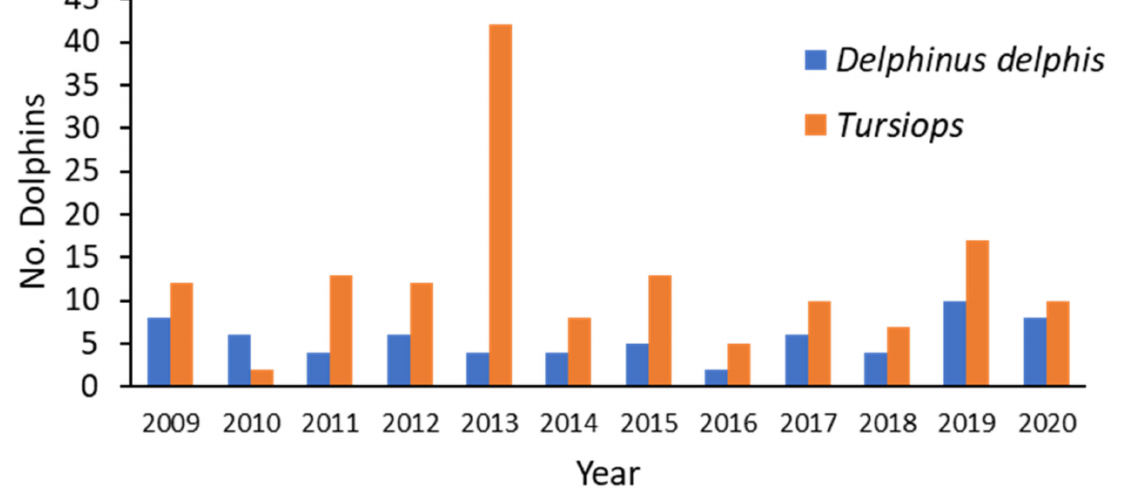
Figure 2. Records of Indo-Pacific bottlenose dolphins ( Tursiops aduncus ) and common dol- phins ( Delphinus delphis ) in the St Vincent Gulf Bioregion, South Australia, each year during the study